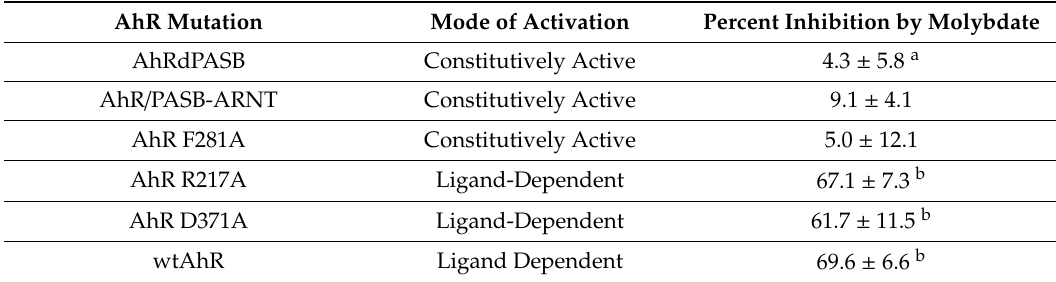
Figure 5. E ff ects of sodium molybdate on AhR transformation. ( a ) Transformation / DNA binding of the in vitro synthesized wtAhR is inhibited by sodium molybdate. The indicated in vitro synthesized AhR constructs were transformed in the presence of increasing concentrations of sodium molybdate for 3 h at room temperature and subjected to gel retardation analysis. For wtAhR, specific protein-DNA complex formation was determined as a di ff erence in band intensities between TCDD (20 nM) and DMSO (1% ( v / v )) reactions. Constitutively active AhRdPASB and AhR / PASB-ARNT were analyzed in the presence of DMSO (1% ( v / v )). PSL = phospho-stimulated luminescence (imager output units). Values represent the mean ± standard deviation of three independent reactions, and the results are representative of three independent experiments. ( b ) Formation of a hsp90:AhR:ARNT ternary protein complex is stabilized by sodium molybdate. [ 35 S]-labeled ARNT and unlabeled AhR were incubated in the presence of 20 nM TCDD (or DMSO (1% ( v / v )) and 20 mM sodium molybdate (or control 20 mM sodium sulfate) for 1.5 h at room temperature prior to hsp90 co-immunoprecipitation. Specific [ 35 S]-ARNT bands were quantitated and the values represent mean ± standard deviation of three independent reactions. Statistical analysis was performed using the Student’s t -test. Results are representative of two independent experiments. Table 1. E ff ects of sodium molybdate on AhR transformation / DNA binding in